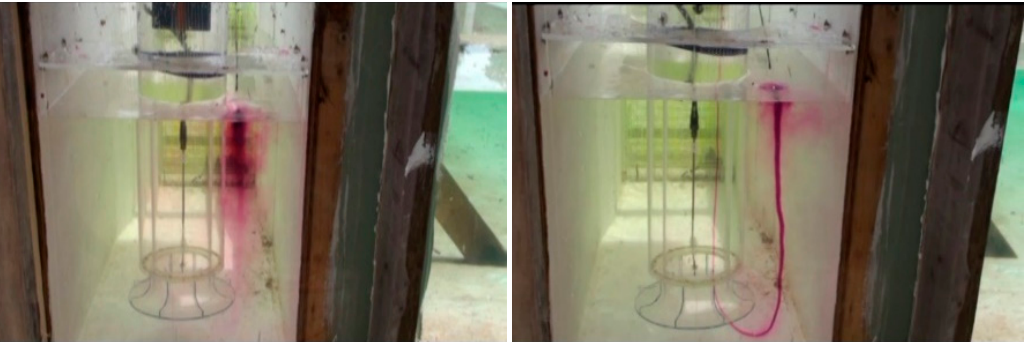
Figure 14. Image shows a free-surface vortex developing from a type 1 surface dimple ( left ) to a type 3 full dye core ( right ) vortex.